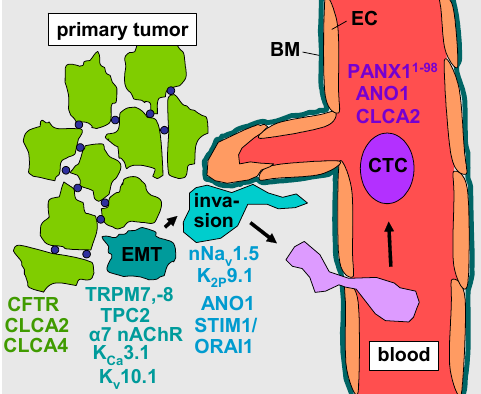
Figure 1. Synopsis of ion channel types involved in evasion of cancer cells from the primary tumor. EMT: epithelial–mesenchymal transition; CTC: circulating cancer cells; EC: endothelial cell; BM: basement membrane. Arrows define the sequence of processes leading to intravasation of the tumor